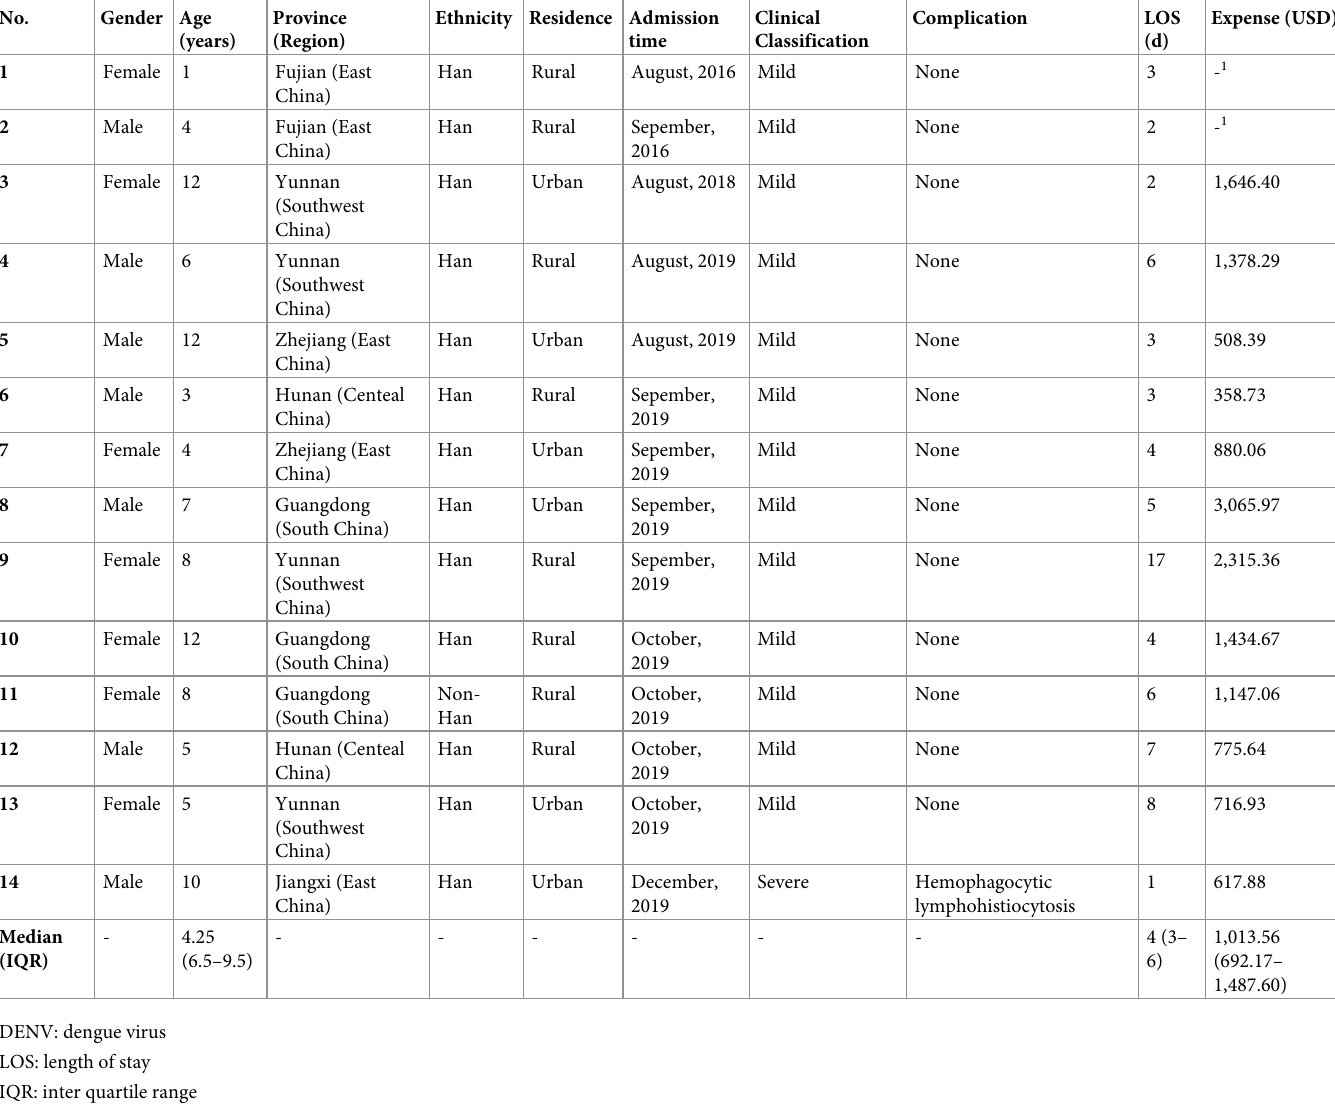
Table 6. The general sociodemographic characteristics and disease burden of DENV infection during pediatric hospitalizations from December 2015 to December 2020.